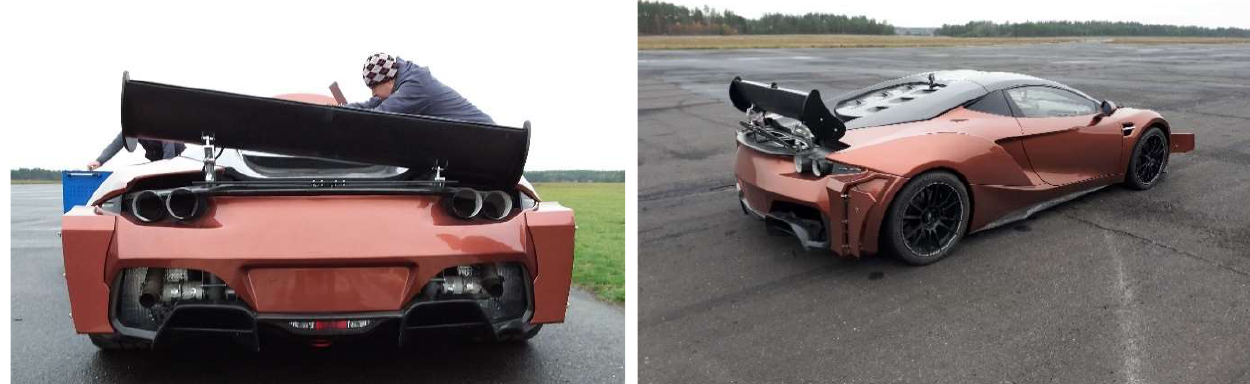
Figure 31. Photographs of the vehicle prepared for passage in two different configurations. Asym- metrically inclined wing for cornering configuration (left) and braking configuration (right).